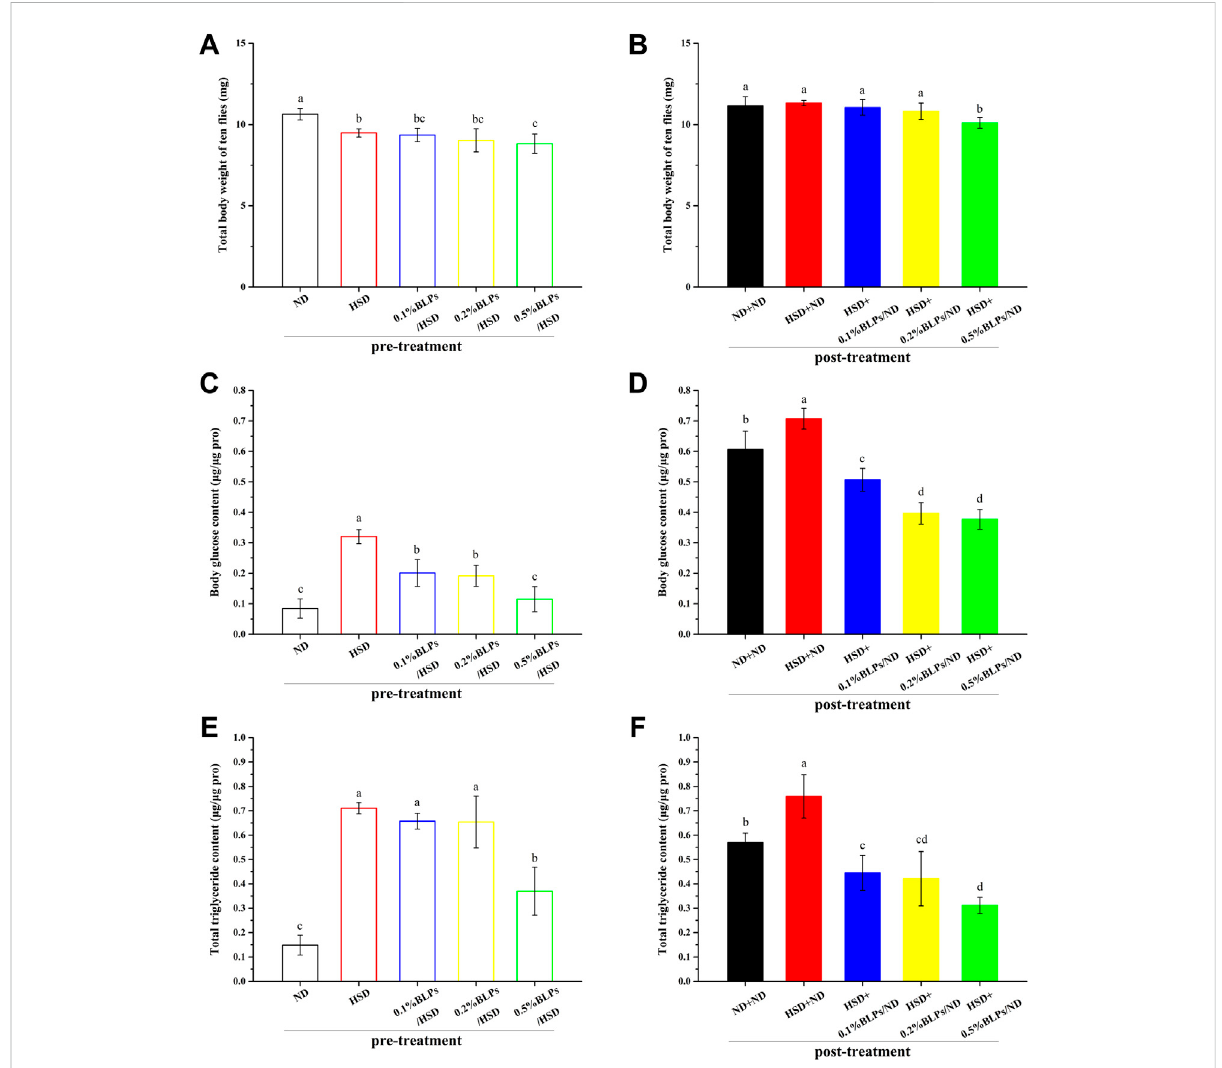
FIGURE 3 Body weight (ten fl ies) (A,B) , body glucose content (C,D) , and total triglyceride content (E,F) of those fl ies fed on a diet containing BLPs at differentconcentrationsinpre-treatmentorpost-treatment,respectively.Valueswithdifferentletters (A – D) representsigni fi cantdifferencesamong the groups ( p <